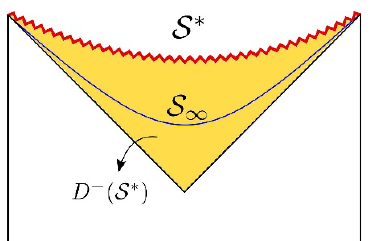
Figure 3 . The total VC complexity flowing into the singular set S ∗ is the volume of the asymptotic surface S ∞ . Its AC analog is the on-shell action integrated over the past domain of dependence D − ( S ∗